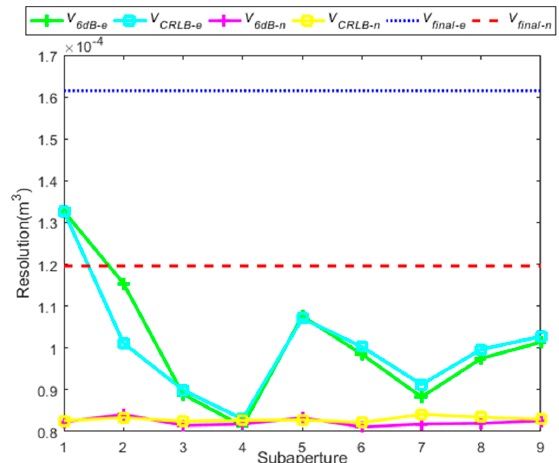
Figure 8. Resolution comparison of imaging results using different sub-aperture partitioning methods.